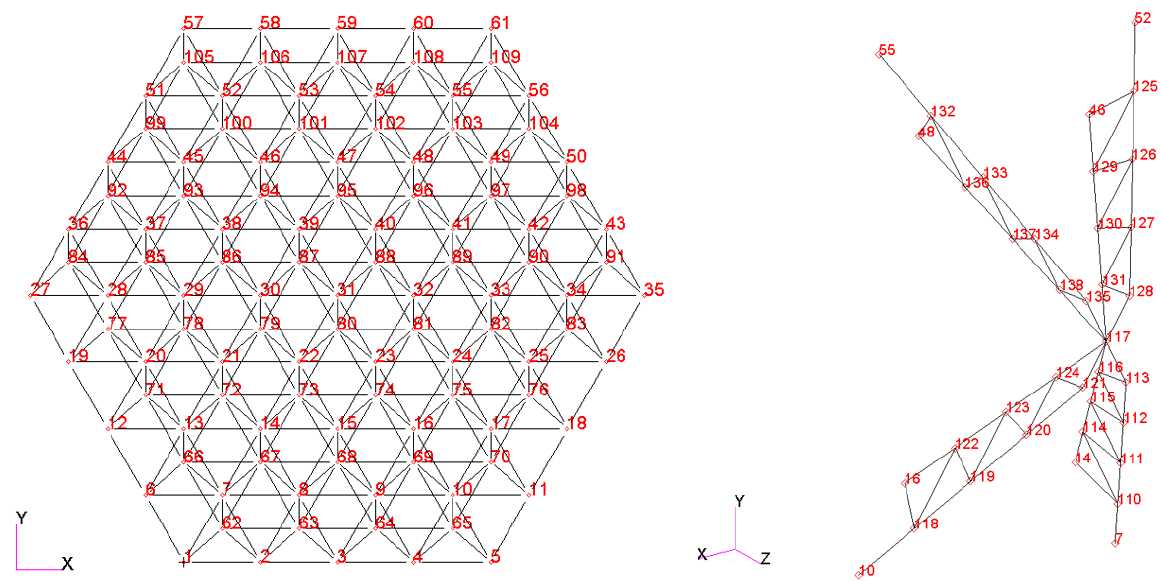
Figure A1. Node numbering description for the truss-like antenna FE model.